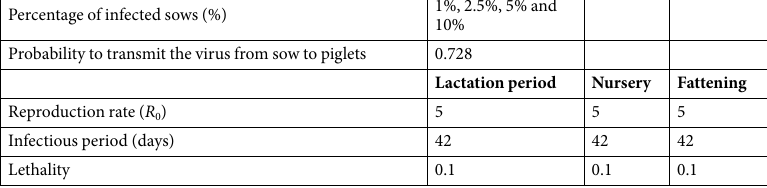
Table 6. Epidemiological parameters used to run the model in a 1000 sow farm.